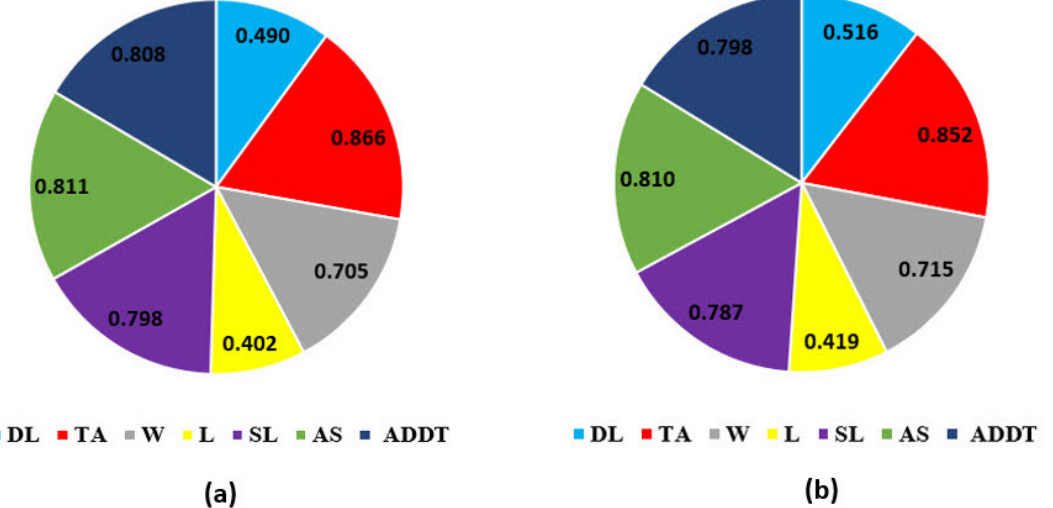
Figure 8. Comparison between the results of sensitivity analysis obtained from the GMDH model ( a ) and GOA-SVM model ( b ).